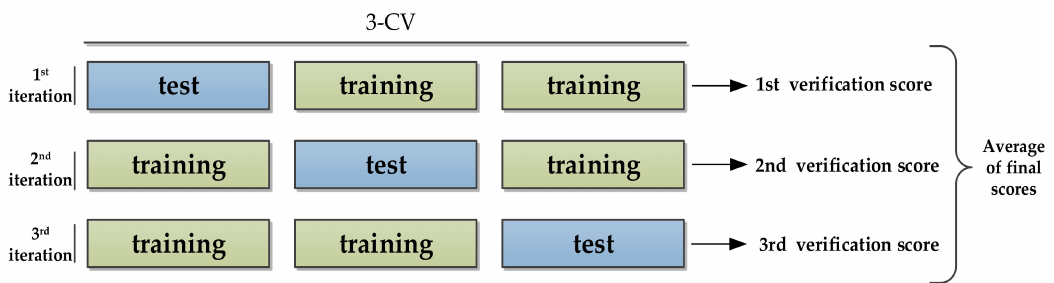
Figure 9. Three-fold cross